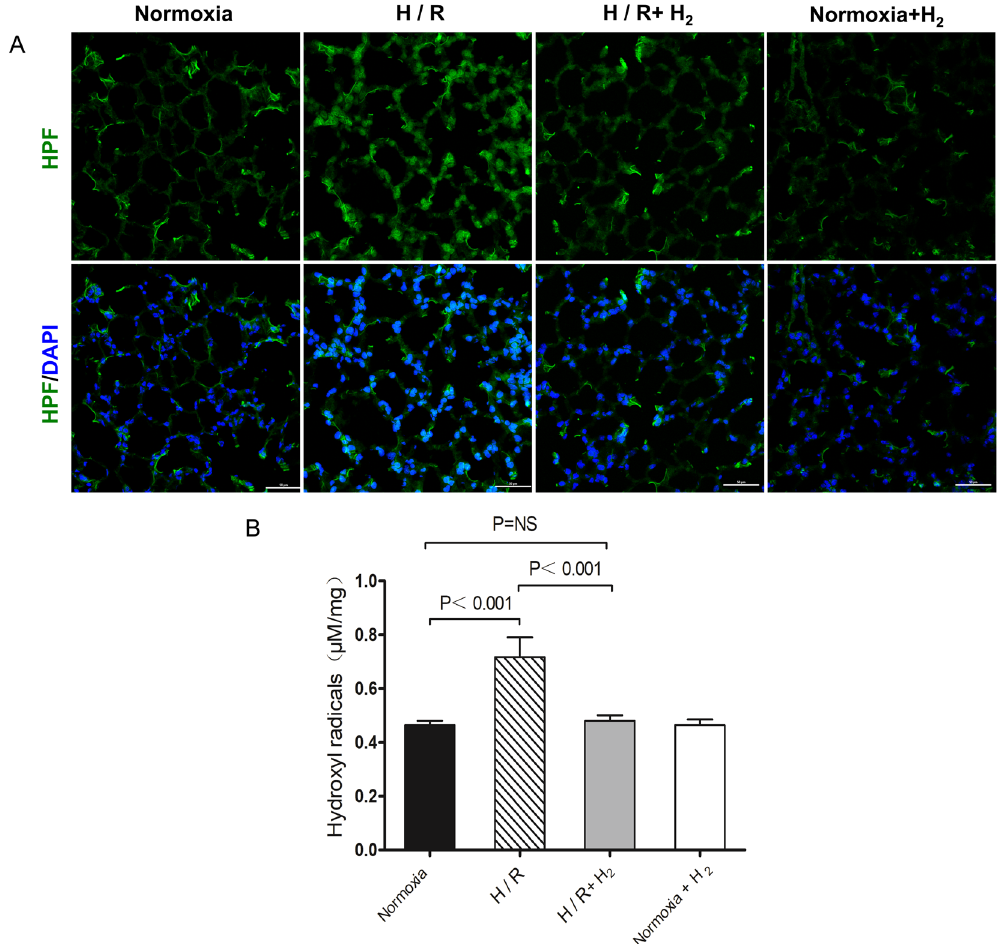
Figure 3. Inhibition of H/R-induced production of hydroxyl radicals by hydrogen. Mice were treated as described in Fig. 1 (n = 6 in each group). Lung samples were harvested, stained for hydroxyl radicals and quantitated. ( A ) Representative staining of lung tissue for hydroxyl radicals (original magnification, × 40). Sections were stained with hydroxyphenyl fluorescein solution and DAPI. Scale bar, 50 μ m. ( B ) Quantitation of hydroxyl radicals in lung tissue. Data shown are mean ± SEM. ns, not